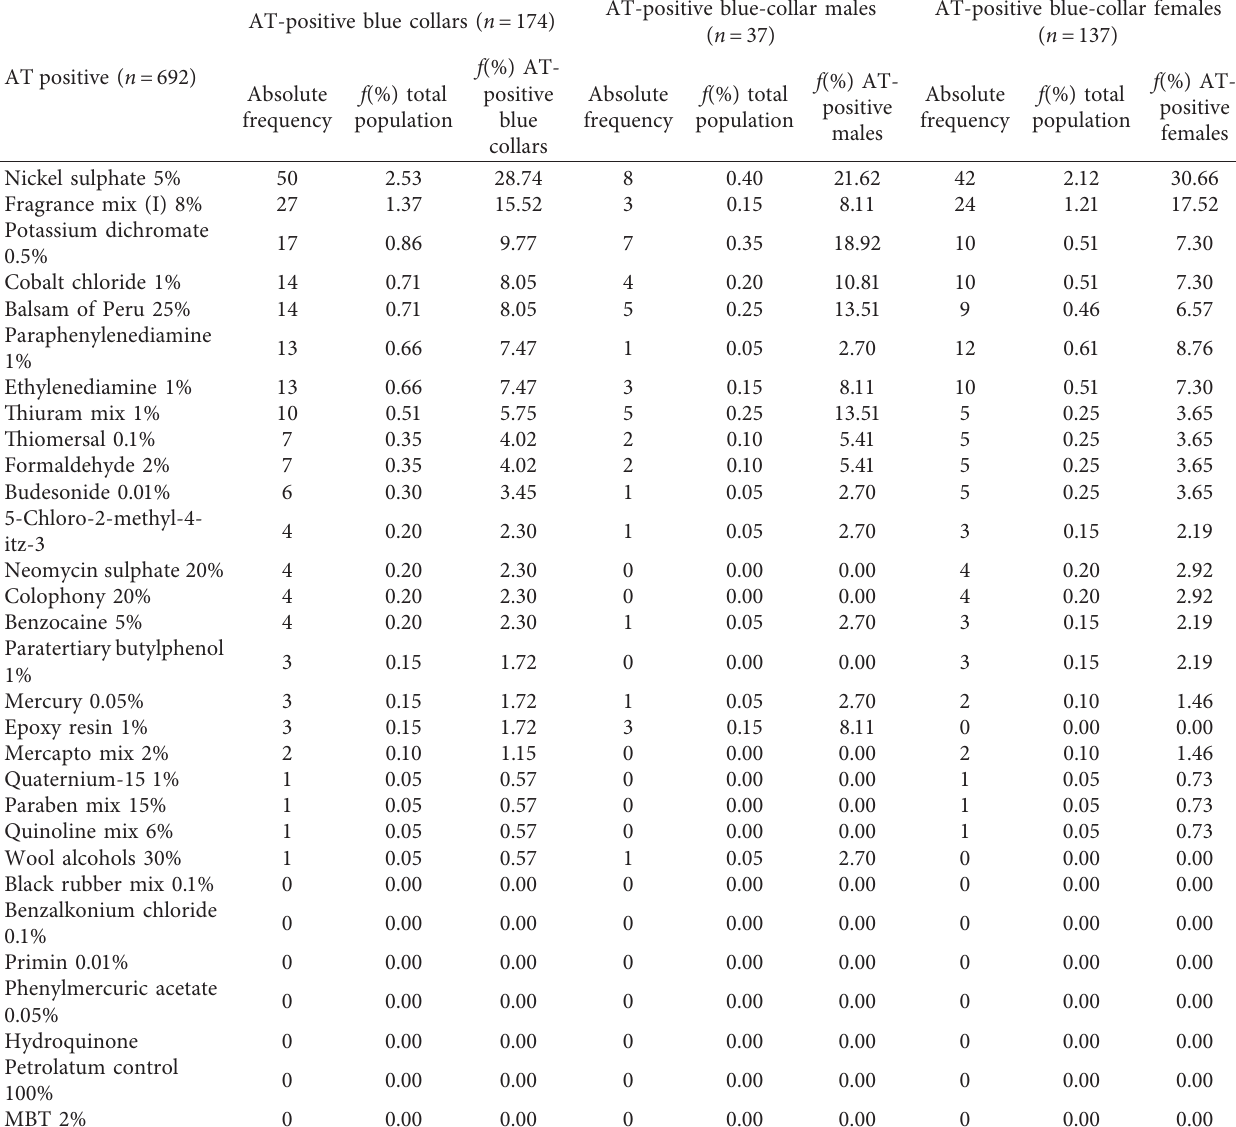
Table 5: Frequencies of the most prevalent allergens in the population with atopic dermatitis (AT), with respect to the blue-collar (BlC) population, as well as the male and female BlC